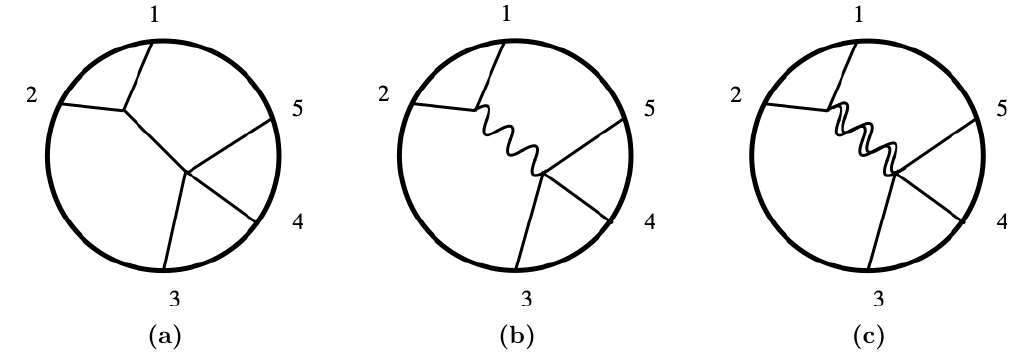
Figure 3. The three types of single-exchange Witten diagrams allowed by R-symmetry selection rules. Here we have suppressed the derivative information in the quartic